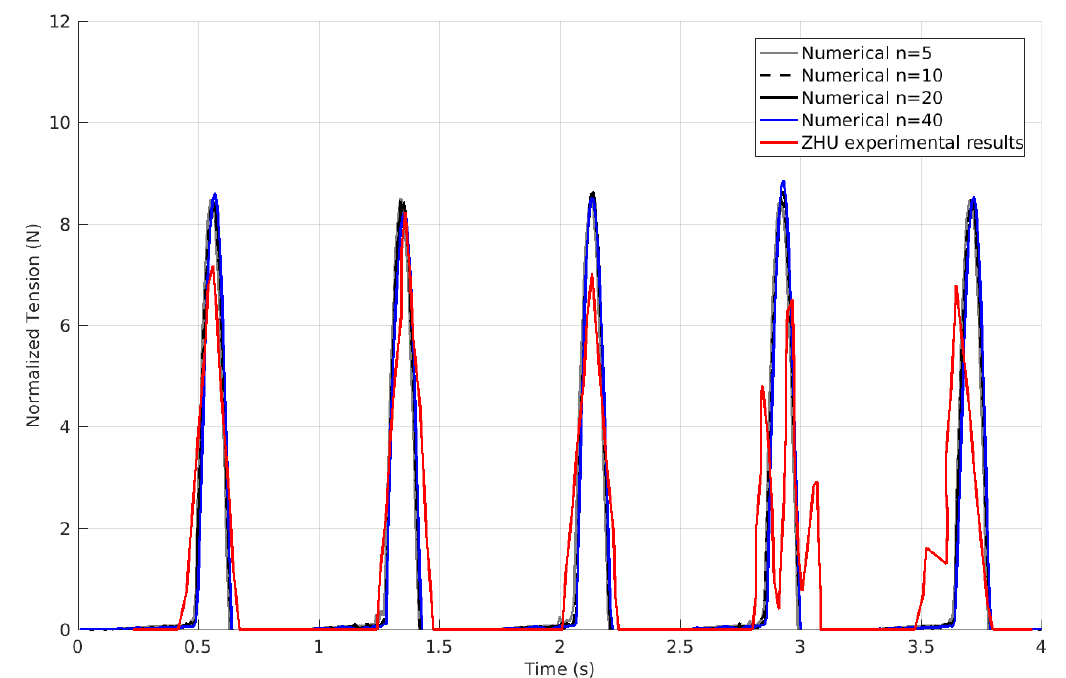
Figure 7. Numerical results for different number of nodes compared with experimental results.